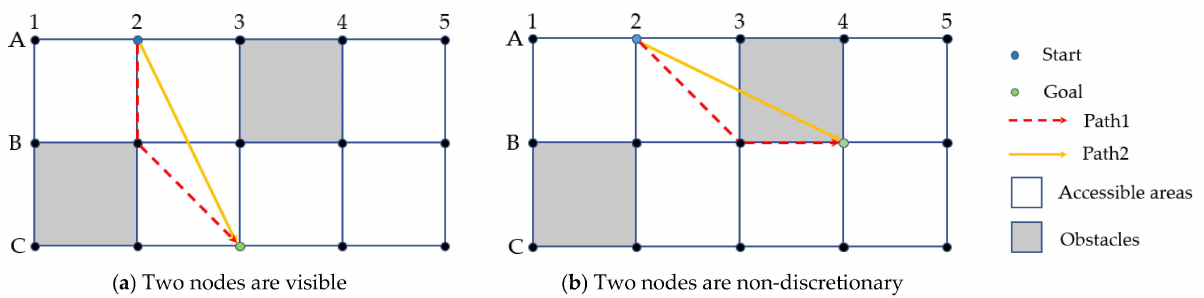
Figure 3. Theta* algorithm path planning